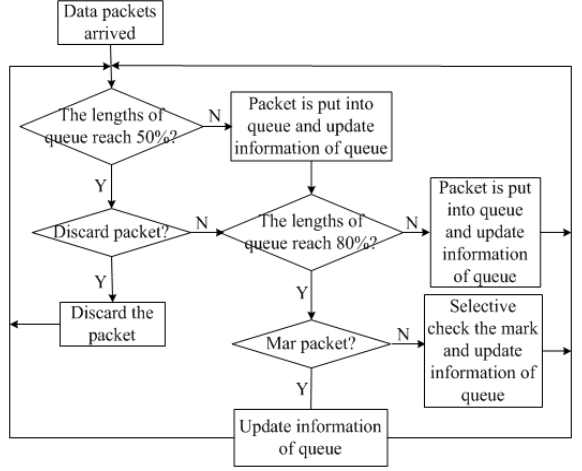
Fig. 8. The flowchart of queue